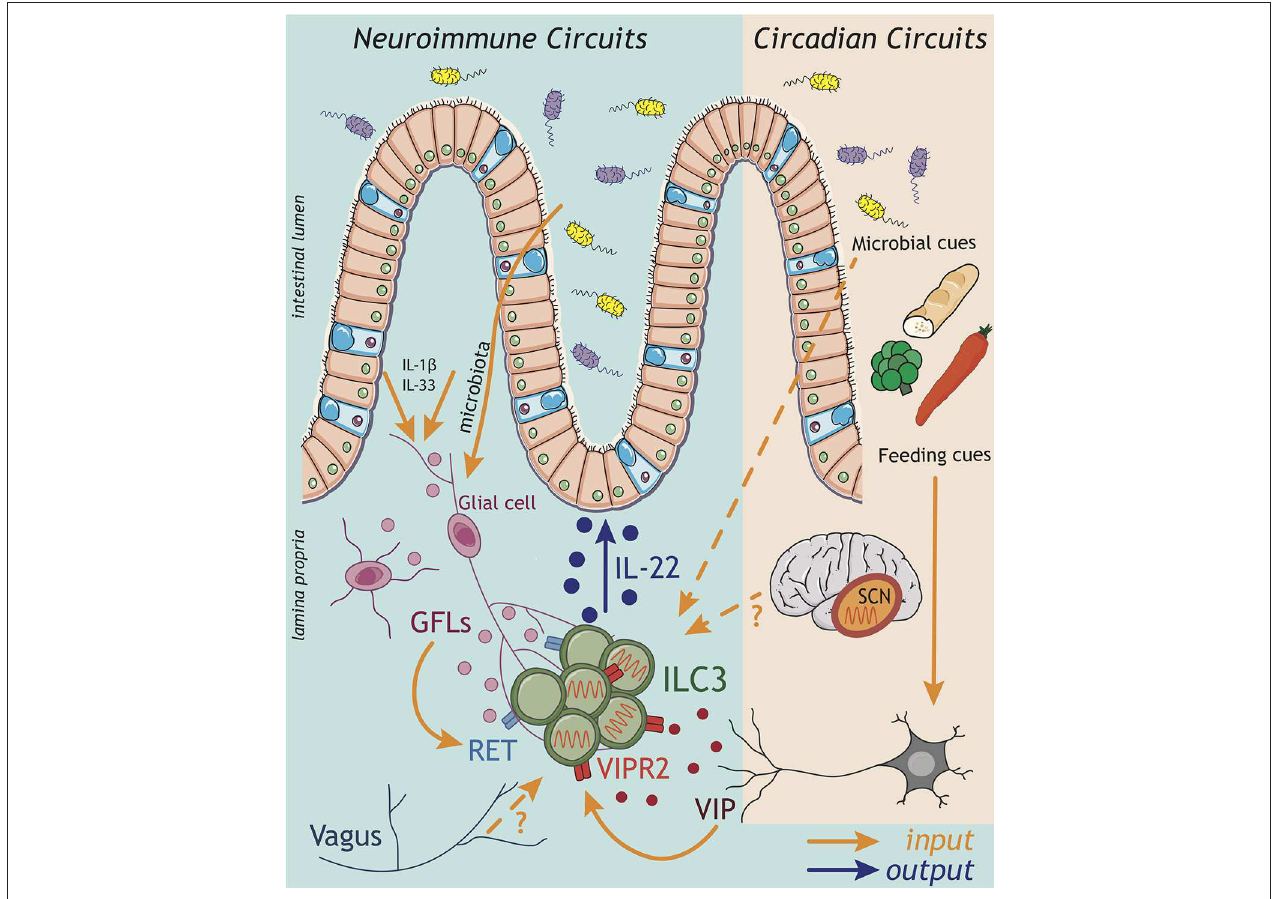
FIGURE 2 | ILC3 neuroimmune and circadian circuits. Emerging findings implicate inputs from the nervous system in the regulation of ILC3 circuits within the gastrointestinal tract. Both the central (CNS) and enteric (ENS) nervous systems have the capacity to sense perturbations within the intestinal environment and relay this information via the release of neuropeptides to influence the ILC3 response. Strikingly, enteric glial cells are able to directly sense microbial patterns and alarmins released within the tissue, and respond by producing glial-derived neurotrophic factors (GDNF family of ligands; GFL) that directly activate the production of IL-22 by ILC3 through the tyrosine kinase RET. Indeed, recent evidence suggests a broader spectrum of neuropeptides may act to regulate ILC3 function including vasointestinal peptide (VIP) produced by enteric neurons in response to feeding cues. Signals transmitted by the nervous system also play critical roles in aligning ILC3 effector function with periods of activity and high risks of environmental exposure and pathogen encounter over the course of a 24h day. In this regard, circadian rhythms entrained by light—and sensed via the suprachiasmatic nucleus (SCN) of the brain—trigger a cascade of molecular transcriptional-translational feedback loops of clock genes, which orchestrate rhythms in the ILC3 response. While the “central clock” within the CNS appears to be a central entrainer of ILC3 oscillatory function in the gut, the mechanisms through which the CNS transmits this information to regulate ILC3 function peripherally remain unknown. Nonetheless, inputs from the CNS have previously been shown to be relayed to ILC3 via the vagus nerve. Together cues from both the CNS and ENS have the potential to entrain intestinal ILC3 function, while circadian rhythms in ILC3 may be imprinted through a combination of central clock-mediated light entrainment, feeding-associated neuronal feedback and environmental cues from the